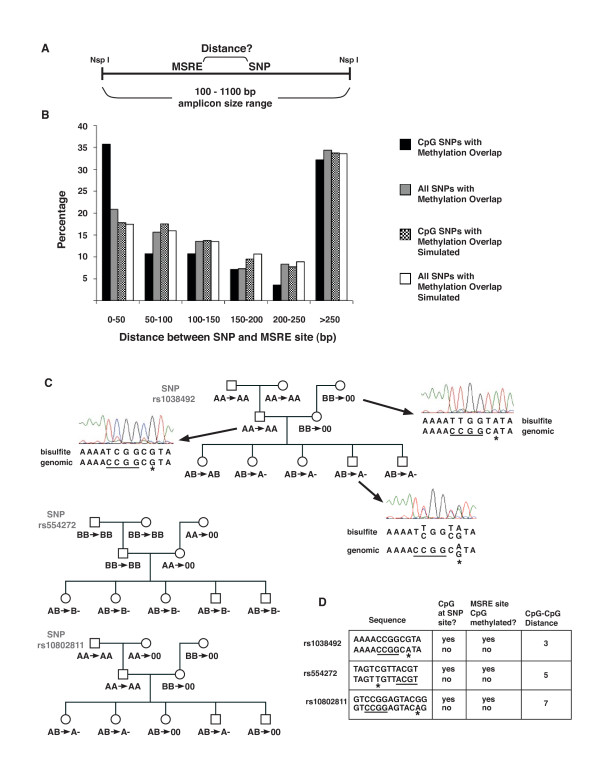
The distribution of the distances between the single nucleotide polymorphisms (SNPs) and the methylation-sensitive restriction enzyme (MSRE) sites present on amplicons displaying methylation overlap. (a) Generic amplicon with a single MSRE site. (b) Percentages of amplicons with given distances between the MSRE and the SNP, for amplicons with one MSRE site; 50 bp bins. See legend. (c) Allelic methylation patterns were analyzed in 10 individuals from three generations (grandparents, parents, children) using array-based methylation assessment (both genotyping and raw intensity assays), and bisulfite sequencing. For the three SNPs shown, the parents were homozygous for opposite alleles and all the children were heterozygous. Array-based genotyping data before and after MSRE treatment are separated by arrows. When the genotype call was homozygous after MSRE treatment, we denoted it as A or B. For the parents and grandparents, when the genotypes were all homozygous (for these SNPs) the genotype after MSRE treatment is displayed as AA or BB, reflecting the likelihood that both alleles were methylated, but the genotype calling would not itself reveal if one allele were unmethylated. Representative bisulfite sequencing results in one individual from each of three generations for the SNP rs1038492. The linked MSRE is underlined and the SNP is indicated with an asterisk. The 'A' allele is consistently methylated both at the SNP CpG and at the MSRE CpG. The 'B' allele is unmethylated at the MSRE site, so its genotype tends to disappear after MSRE treatment; upon bisulfite treatment, the 'B' allele has the C that is part of the CpG within the MSRE completely converted to T. (d) For SNPs in which one allele is a CpG, the SNP CpG was itself methylated along with the linked CpG within the MSRE.